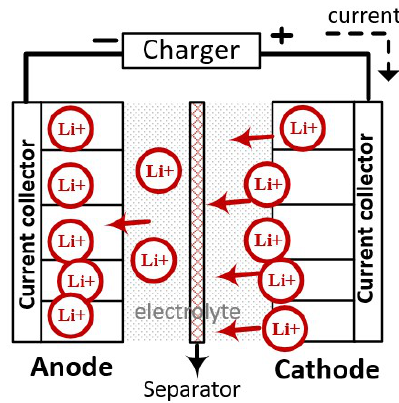
Figure 1 . Schematic illustration of the charging process in a lithium-ion polymer (LiPo) battery.